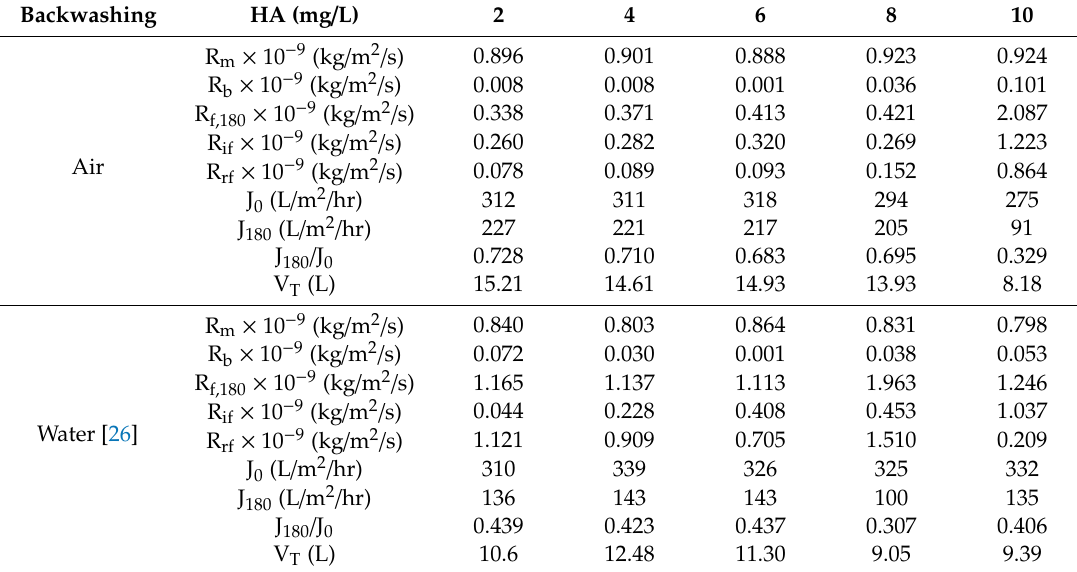
Table 6. Influence of humic acid on separation elements in the integrated water treatment system, of multichannel ceramic MF and pure PP particles, using air backwashing (FT 10 min, BT 10 s); paralleled with outcomes of water